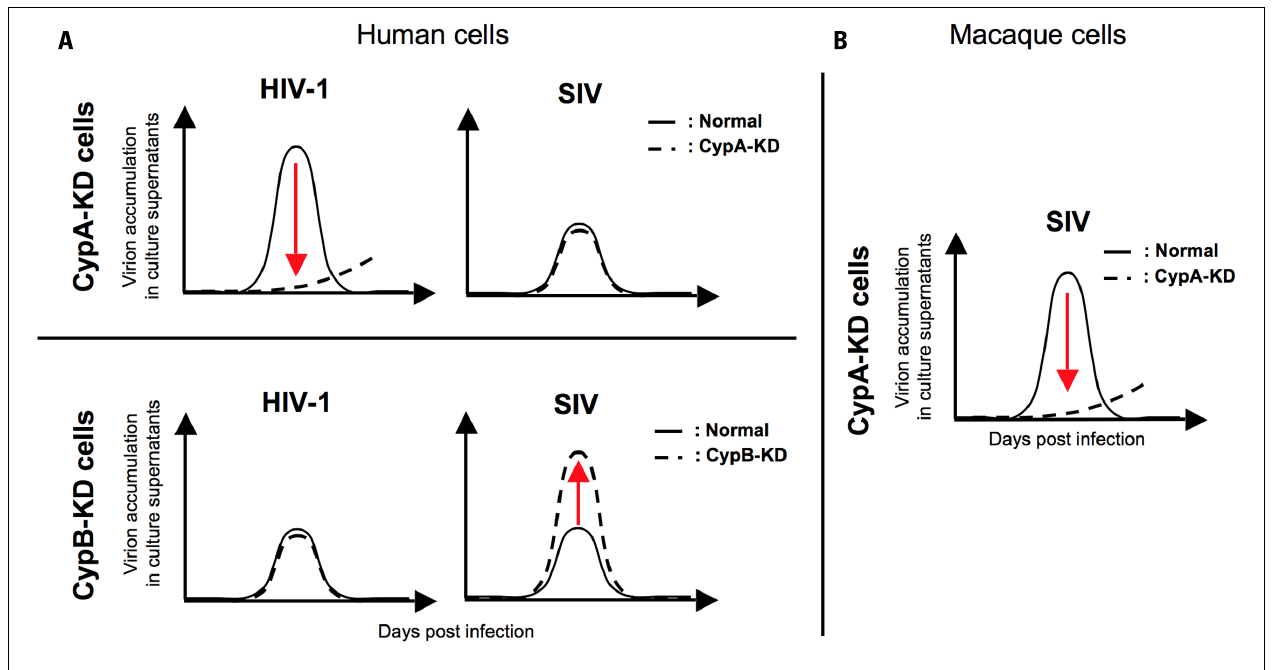
replication (lower left panel) but enhances the replication of SIV (lower right panel). (B) CypA-KD inhibits SIV infection.The solid line indicates virion accumulation of culture supernatant produced from normal cells and the broken line indicates that of culture supernatant produced from CypA or CypB knock-down